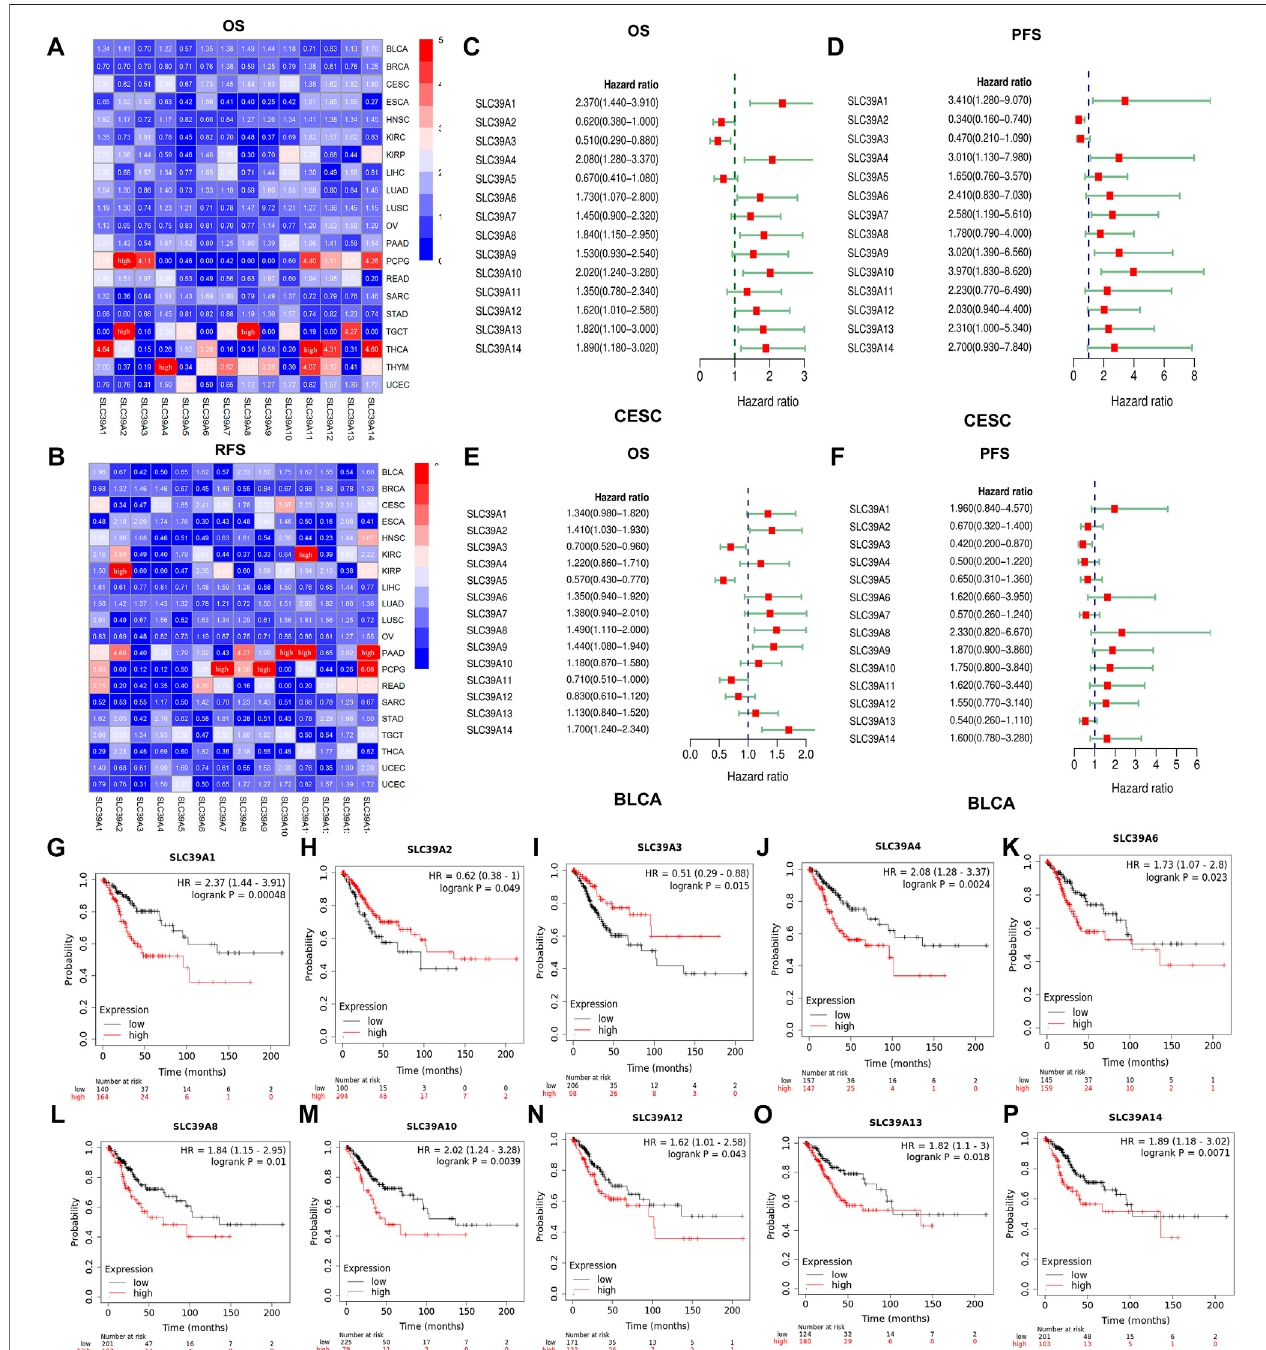
FIGURE 4 | Survival analysis of the prognostic value of the SLC39A family genes in pan-cancer derived from the KM-plotter dataset. (A) Heat map shows the hazard ratio (HR) value of the OS in pan-cancer calculated using the KM-plotter database. (B) Heat map shows the hazard ratio (HR) value of the RFS in pan-cancer calculated using the KM-plotter database. (The colors from blue to red represent the range of HR values in the fi gure. HRs over 5 were replaced with “ high. ” ) (C) Forest plot quantitatively synthesizesthe HR and 95% con fi dence interval of the OS ofthe SLC39A gene family in CESC. (D) Forest plot quantitatively synthesizes the HR and 95% con fi dence interval of the PFS of the SLC39A gene family in CESC. (E) Forest plot quantitatively synthesizes the HR and 95% con fi dence interval of the OS of the SLC39A gene family in BLCA. (F) Forest plot quantitatively synthesizes the HR and 95% con fi dence interval of the PFS of the SLC39A gene family in BLCA. (G) Survivalcurveof SLC39A1 ontheOSinCESC. (H) Survivalcurveof SLC39A2 ontheOSinCESC. (I) Survivalcurveof SLC39A3 ontheOSinCESC. (J) Survivalcurveof SLC39A4 ontheOSinCESC. (K) Survivalcurveof SLC39A6 ontheOSinCESC. (L) Survivalcurveof SLC39A8 ontheOSinCESC. (M) Survivalcurveof SLC39A10 on the OS in CESC. (N) Survival curve of SLC39A12 on the OS in CESC. (O) Survival curve of SLC39A13 on the OS in CESC. (P) Survival curve of SLC39A14 on the OS in CESC. The red line and the blue line represent high and low expression, respectively. The Cox p -value cut-off value was set to 0.05.